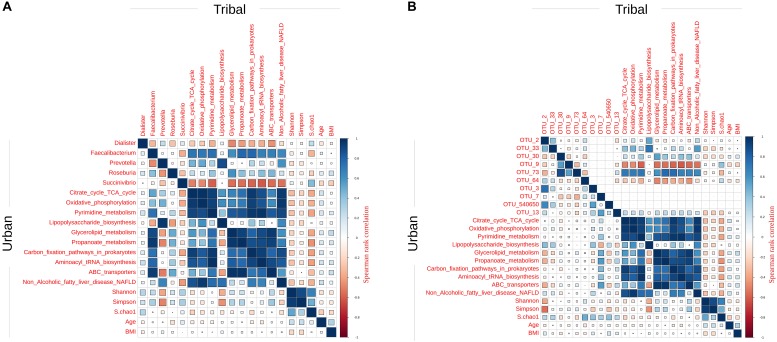
Correlation plots for Spearman rank correlations obtained using features that had a significantly different abundance in the tribal and urban cohorts. Statistically significant Spearman rank correlations obtained using (A) differentiating genera and (B) differentiating OTUs along with differentiating functions, diversity indices, age, and BMI. The upper triangle of the correlation plot demonstrates correlations in the tribal cohort while the lower triangle represents correlations in the urban cohort.